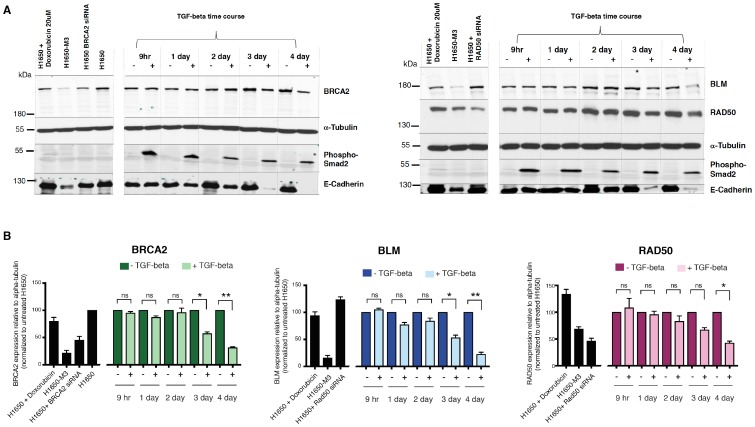
TGF-β signaling controls the expression of multiple HDR genes at the protein level.(A) Western blot analysis of the expression of BRCA2, BLM and RAD50 upon vehicle or TGF-β treatment (9 hr, 1 day, 2 day, 3 day or 4 day) in H1650 cells. Phospho-Smad2 and E-cadherin are used as a marker of active TGF-β signaling and MET, respectively. α-Tubulin is used as a loading control. (B) The charts depict the quantification of the relative amounts of BRCA2, BLM and RAD50. Levels of intensity of each band were quantified using imajeJ32 software, represented as a ratio of the protein of interest to α-tubulin, and normalized to levels detected in respective TGF-β untreated (–TGF-β) samples. The data represent the mean ± SD from two independent experiments. p-value *<0.005, ***<0.001, unpaired t-test with Welch’s correction.